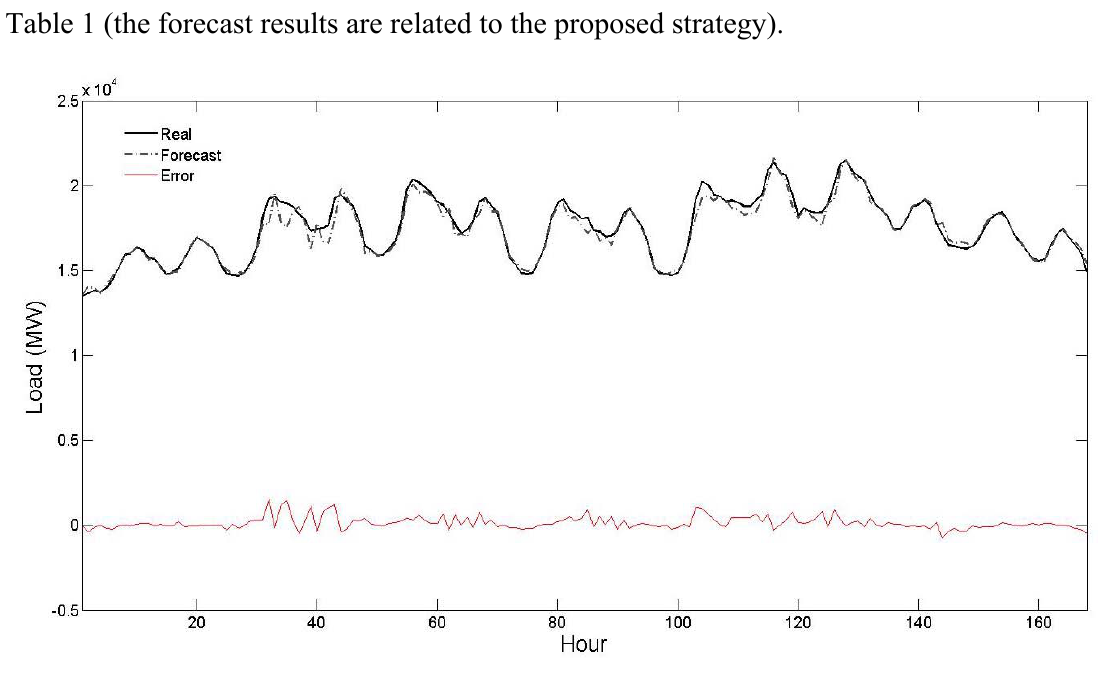
Figure 3. Curves of real values, forecast values and forecast errors for the second test week of Table 1 (the forecast results are related to the proposed